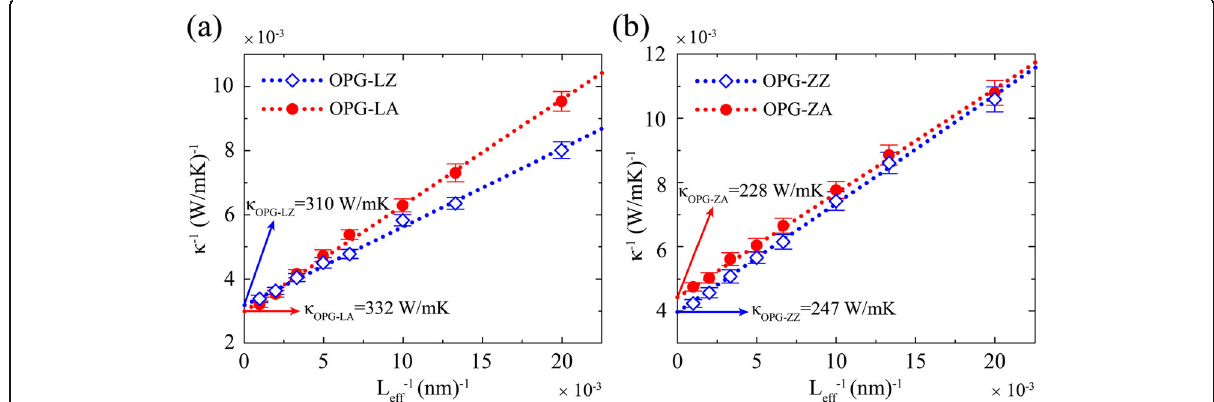
Fig. 4 Inverse TC of a OPG-L and b OPG-Z as a function of the inverse length of the sample at 300 K. The open blue diamond and red spots represent TC along the zigzag and the armchair directions,